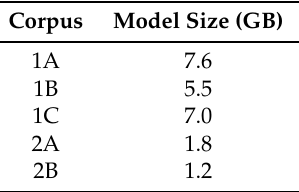
Table 2. W2V models